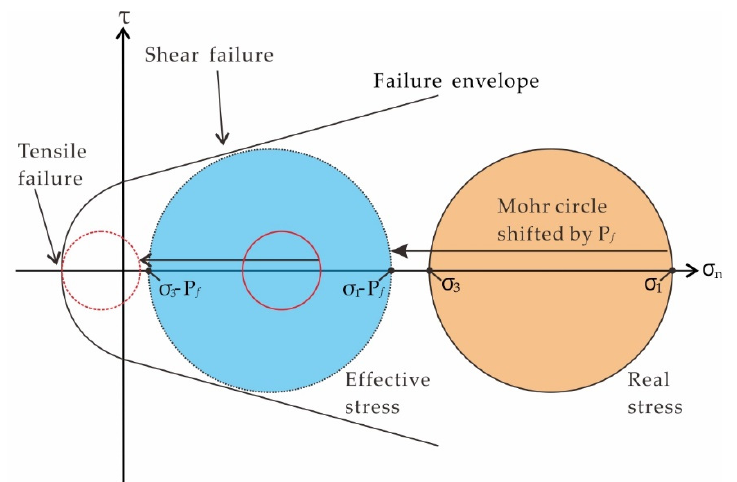
Figure 13. Schematic diagram showing formation mechanism for overpressure fractures (modified from Bons et al. [63] and Gong et al.